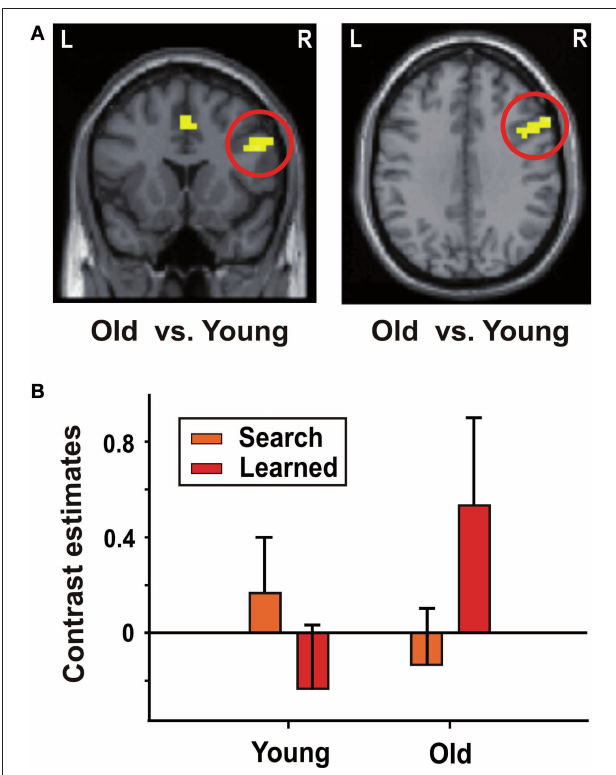
FIGURE 3 | Decision making – interaction of learning stage and age. (A) Interaction of learning stage × age in the right dlPFC ( x = 52, y = 16, z = 28). (B) Contrast estimates (mean, standard error) of “learned” and “search” trials in younger and older participants in the right dlPFC.